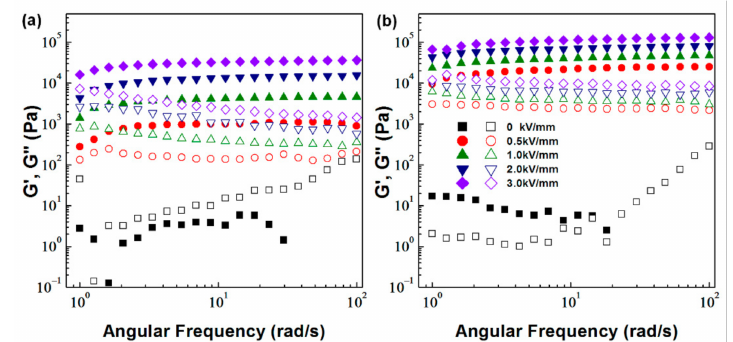
Figure 7. Frequency sweeps of the ER fluids based on cellulose ( a ) and cellulose/Laponite composite ( b ) measured at various electric field strengths (G’: closed symbol; G”: open